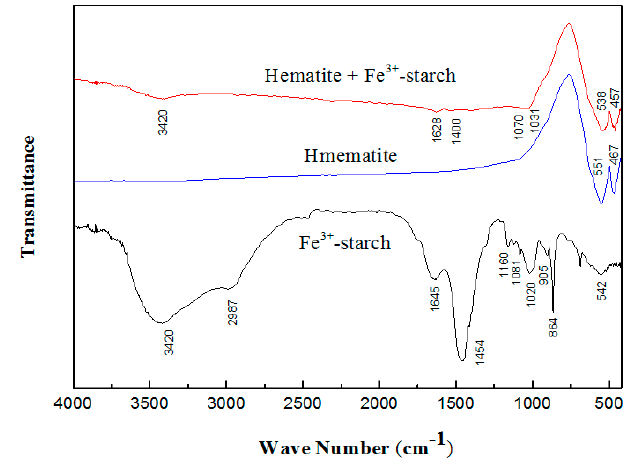
Figure 9. FTIR spectra of hematite conditioned with the Fe 3+ -starch (MSC).